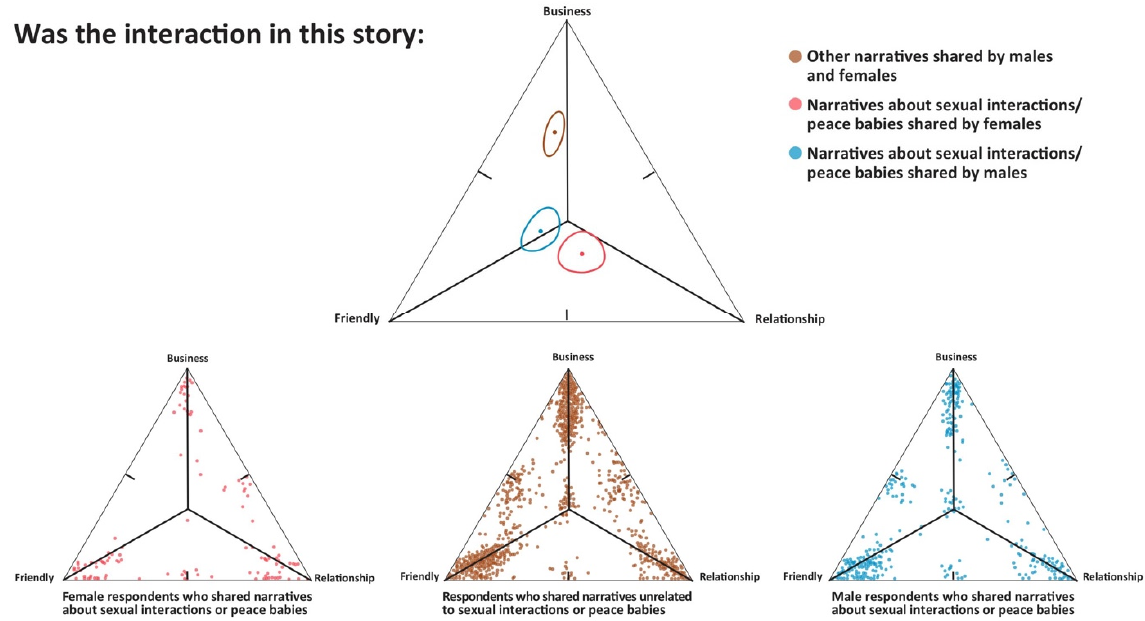
Figure 6. Disaggregated geometric means for Triad 3.